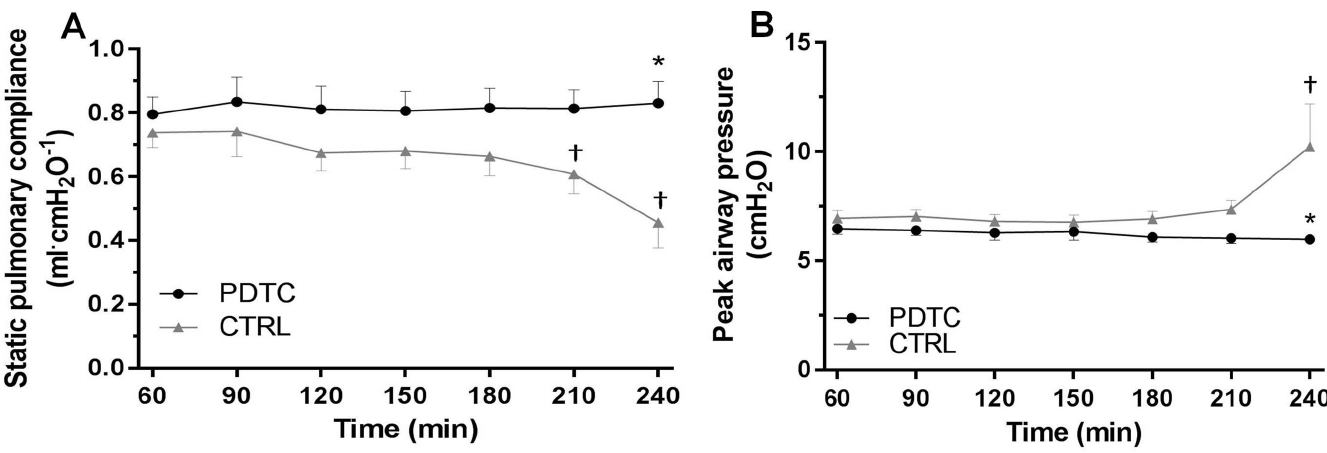
Fig 5. Static pulmonary compliance and peak airway pressureduring EVLP. Static pulmonary compliance(A) and peak airway pressure (B) were computed60 minutes after EVLP initiation(baselinevalues), and every 30 minutes thereafter. CTRL: Ischemia followedby EVLP with Steen ® solution alone (N = 6); PDTC: Ischemia followedby EVLP with PDTC treatment (N = 6). Means ± s.e.m. † p < 0.05 vs baselinevalue; * p < 0.05PDTC vs CTRL (two way ANOVA with Bonferroni’s adjustmentsfor multiplescomparisons)